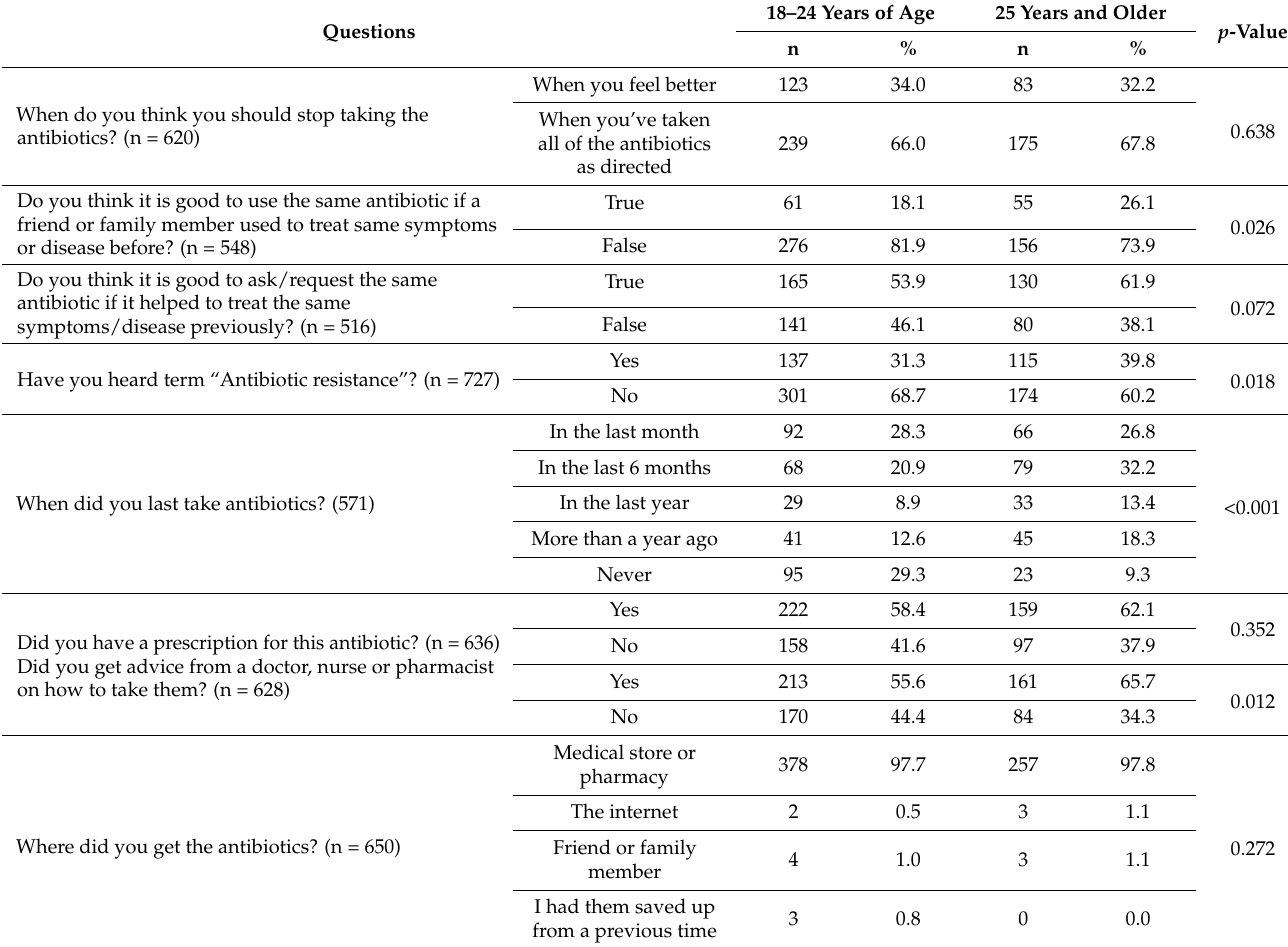
Table 3. Awareness about antibiotic use and resistance by age.